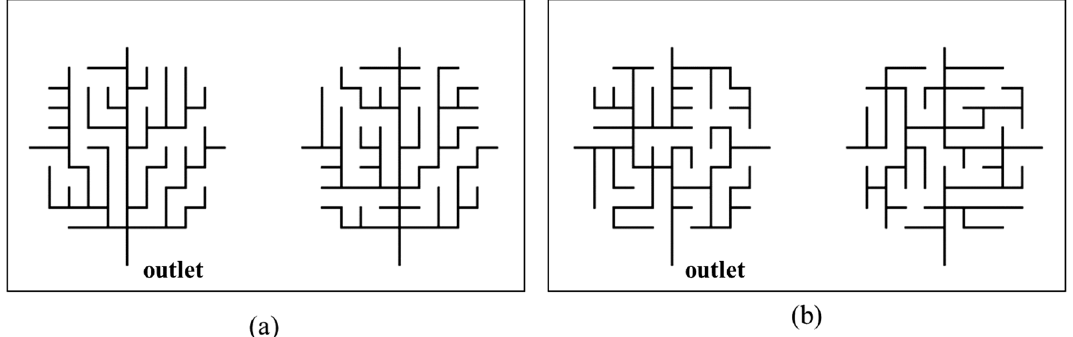
Figure 3. Drainage Networks generated by Gibbs’ model with ( a ) β = 10 3 to generate simple network topology to the drainage outlet (down point) and ( b ) β = 10 − 4 to generate complex network topology to the drainage